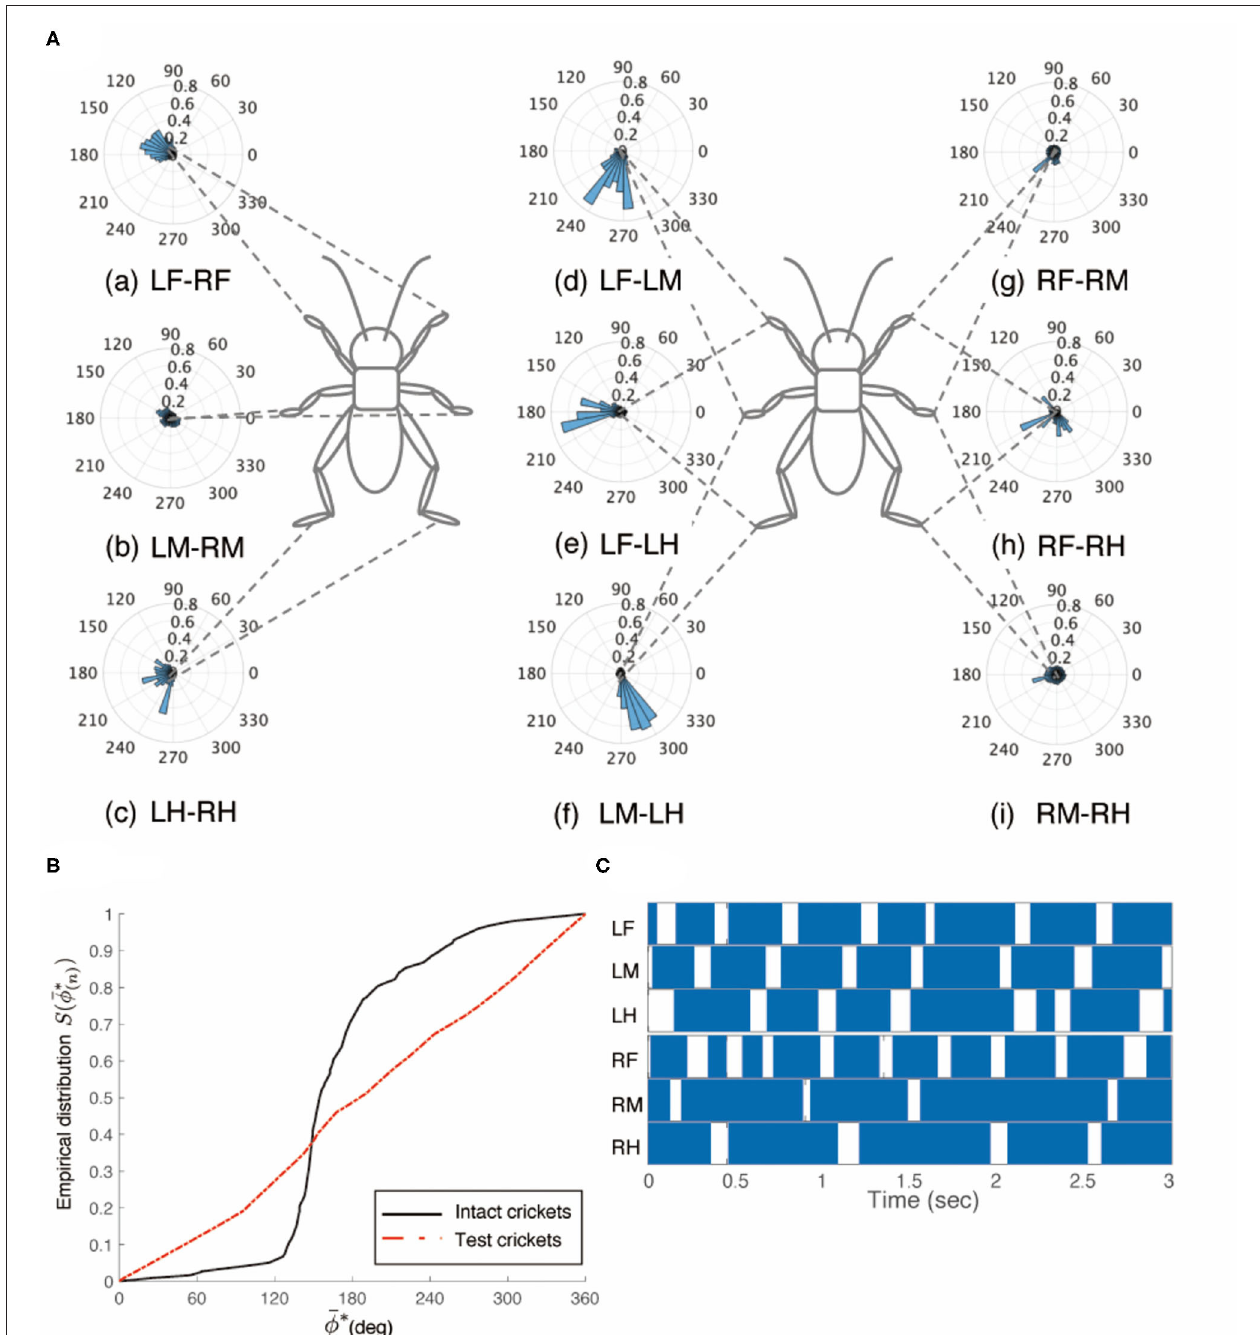
FIGURE 3 | Walking gait patterns of crickets in which left side of nerve connectives between brain and SEG was cut. (A) Polar histograms indicate phase differences between two legs in test crickets ( N = 5). The test crickets continued to turn clockwise. The polar histograms demonstrate that the walking pattern was not a tripod gait. (a–i) Phase differences between pairs of legs. (B) Comparison of the empirical distribution function of leg phase differences between left and right legs Φ LM − RM . The black line indicates the empirical distribution function of the intact crickets and the red line indicates that of the test crickets. (C) Gait chart diagram of test cricket. The filled part indicates the duration of the power stroke period and the blank part indicates the duration of the recovery stroke. This also demonstrates that the walking pattern was not a tripod gait in the test cricket. LF, left foreleg; RF, right foreleg; LM, left midleg; RM, right midleg; LH, left hind leg; RH, right hind leg.